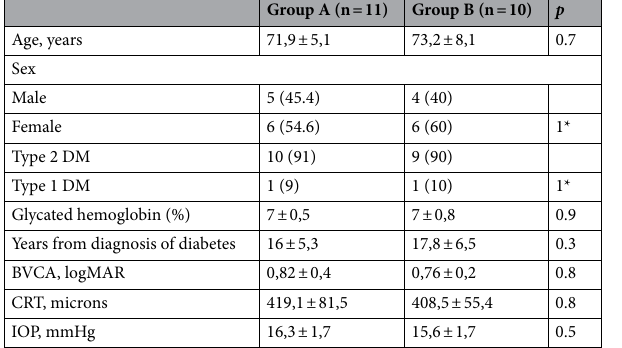
Table 1. Demograpic and baseline characteristics. DM Diabetes mellitus, BCVA Best corrected visual acuity, CRT Central retinal thickness, IOP Intraocular pressure. Unless otherwise indicated, values are mean ± SD or no. (%). p , Mann–whitney U test, *, Fisher’s exact